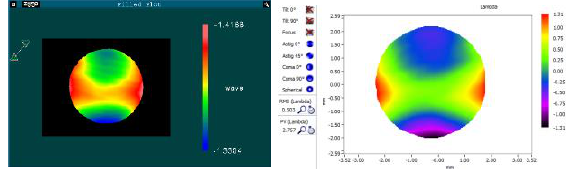
Fig. 3. (Left) measurement made with a Fizeau interferometer (reference model), the computed wavefront error is 2.74 λ PV. (Right) measurement made with a SH wavefront sensor, the computed wavefront error is 2.75 λ